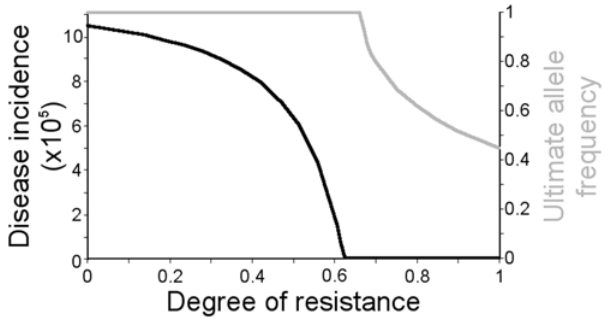
Figure 3. Increase in ultimate allele frequency (top line) and disease incidence (bottom line) with declining degree of resistance conferred by the resistance allele. Degree of resistance is defined as the reduction in the probability of infection compared with a genetically susceptible individual.